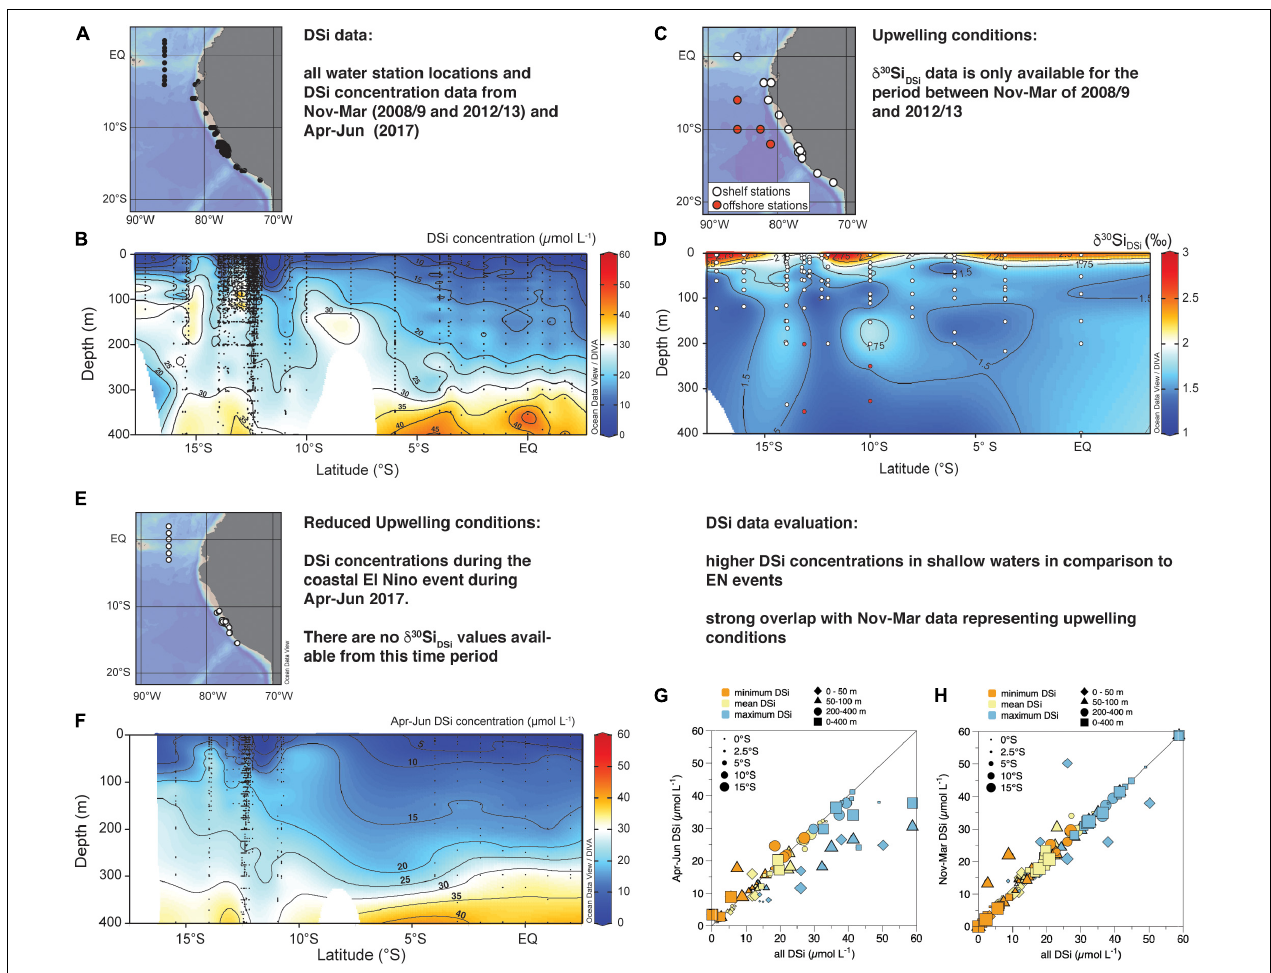
FIGURE 2 | Water sampling locations for (A) DSi concentrations ( µ mol L − 1 ) and (C) δ 30 Si values of DSi ( δ 30 Si DSi ) along the Peruvian coast; (B) . North-South sections of mean DSi concentrations from cruises M77, M90, M93, M136, M137, and M138 for all water stations from 0–400 m water depth; (D) North-South sections of δ 30 Si DSi for all water column stations occupied during cruises M77 and M93, white dots indicate shelf stations, red dots indicate offshore stations; please note that offshore stations were only incorporated into data for 200–400 m due to the few data available for these depths of the shallow shelf stations (white dots); (E) Seasonal water sampling locations for DSi concentrations ( µ mol L − 1 ) during cruises M136, 137, and 138 from April to June 2017 (El Niño); (F) DSi concentrations along the North-South transect during cruises M136, 137, and 138 from April to June 2017 (El Niño); Sections were plotted applying the DIVA interpolation of Ocean Data View (Schlitzer, 2020); (G) Comparison of the calculated DSi concentrations and measured Apr-June (2017) DSi concentration per degree latitude (as given in Table 2 ); (H) Comparison of the calculated DSi concentrations and measured Nov-Mar (2008/9 and 2012/13) DSi concentration per degree latitude; DSi concentrations are differentiated into minimum (orange), mean (yellow), and maximum (blue) and differentiated into the habitat depth of the studied radiolaria taxa of 0-50 m (diamonds), 50–100 m (triangles), 200–400 m (circles), and 0–400 m (squares). DSi concentrations are given as minimum (orange), mean and maximum; Correlations are performed for each habitat depth of 0–50 m (A,B) , 50–100 m (C,D) , 200–400 m (E,F) , and 0–400 m (H,G) . The size of the symbols indicates the latitude, with the smallest symbols representing stations close to the equator and the largest circles marking stations at 16.5 ◦ S. The black line indicates the 1:1